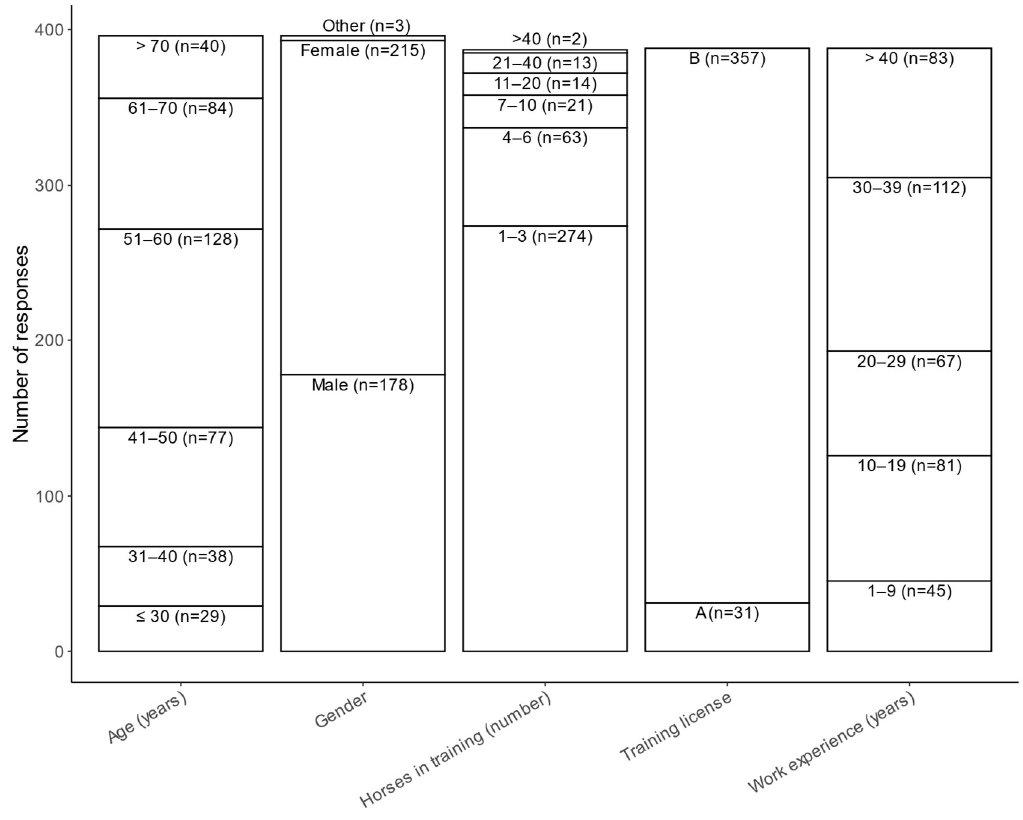
Figure 1. Descriptive information on respondents.